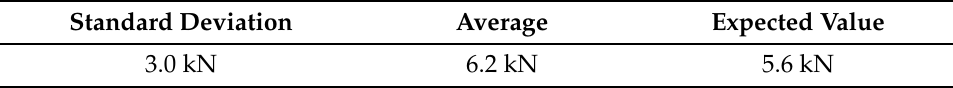
Figure 5. Distribution of experimentally measured prestressing forces in all the cables. Table 3. Pre-loading